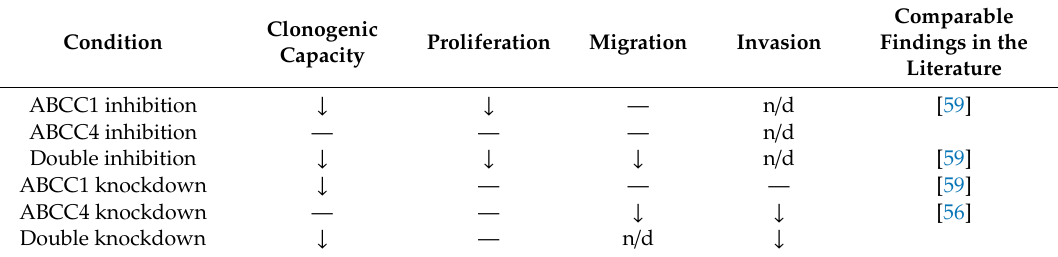
Table 2. Summary of findings. ↓ significant decrease. — no significant e ff ect. n / d not